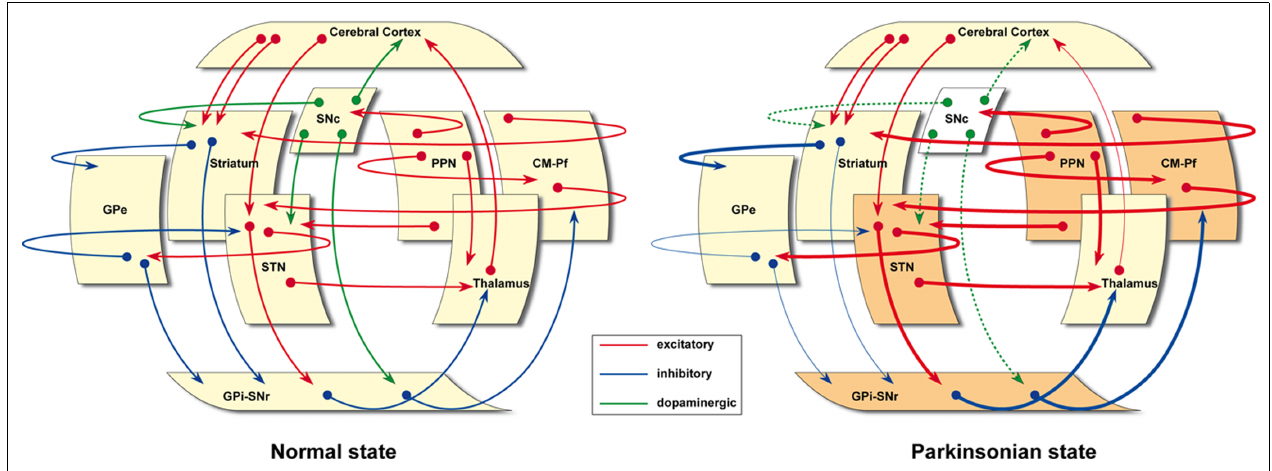
according to available experimental evidences. Furthermore, it is also worth noting that these cartoons emphasize the presence of a number of transverse, modulatory loops that have often been neglected in the classic BG